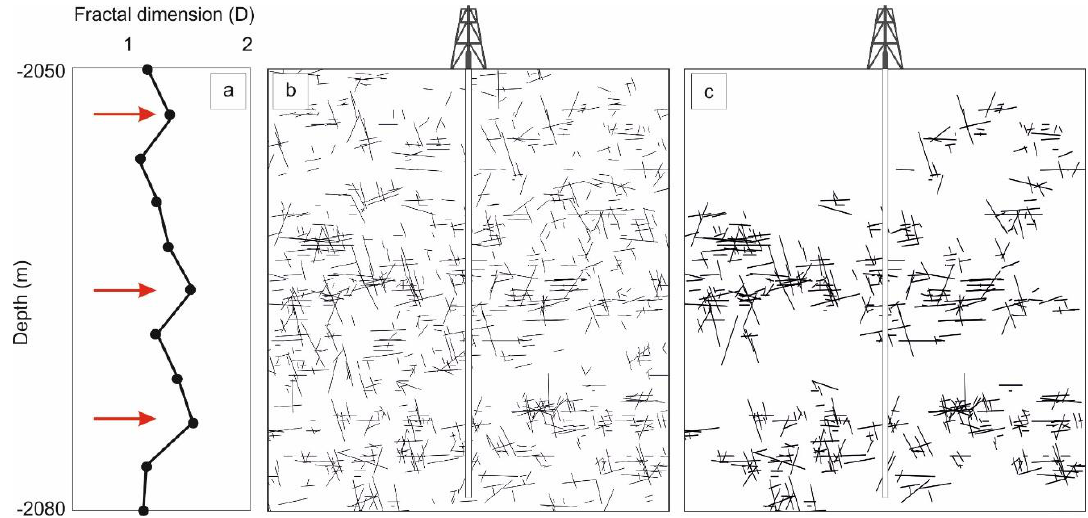
Figure 11. Representative fracture network model. ( a ) Fractal dimension ( D ) log. Red arrows denote the intervals with high fracture density. ( b ) Representative vertical section of the total fracture network around the A-1 well. ( c ) Communicating part of the same fracture network.